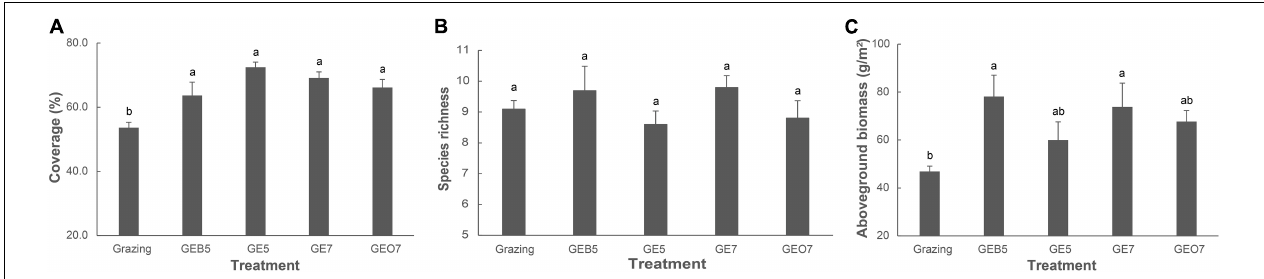
years, GE7; Grazing exclusion over 7 years, GEO7.